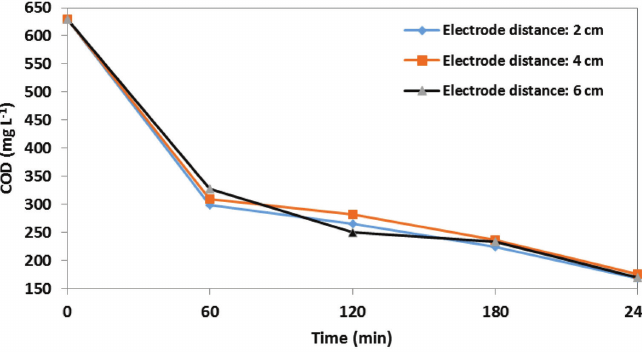
Fig. 3 – Effect of electrode distance on COD removal of high salinity petrochemical wastewater using PPc (Voltage: 1.5 V, pH = 4, reaction time: 240 min, uV lamps: